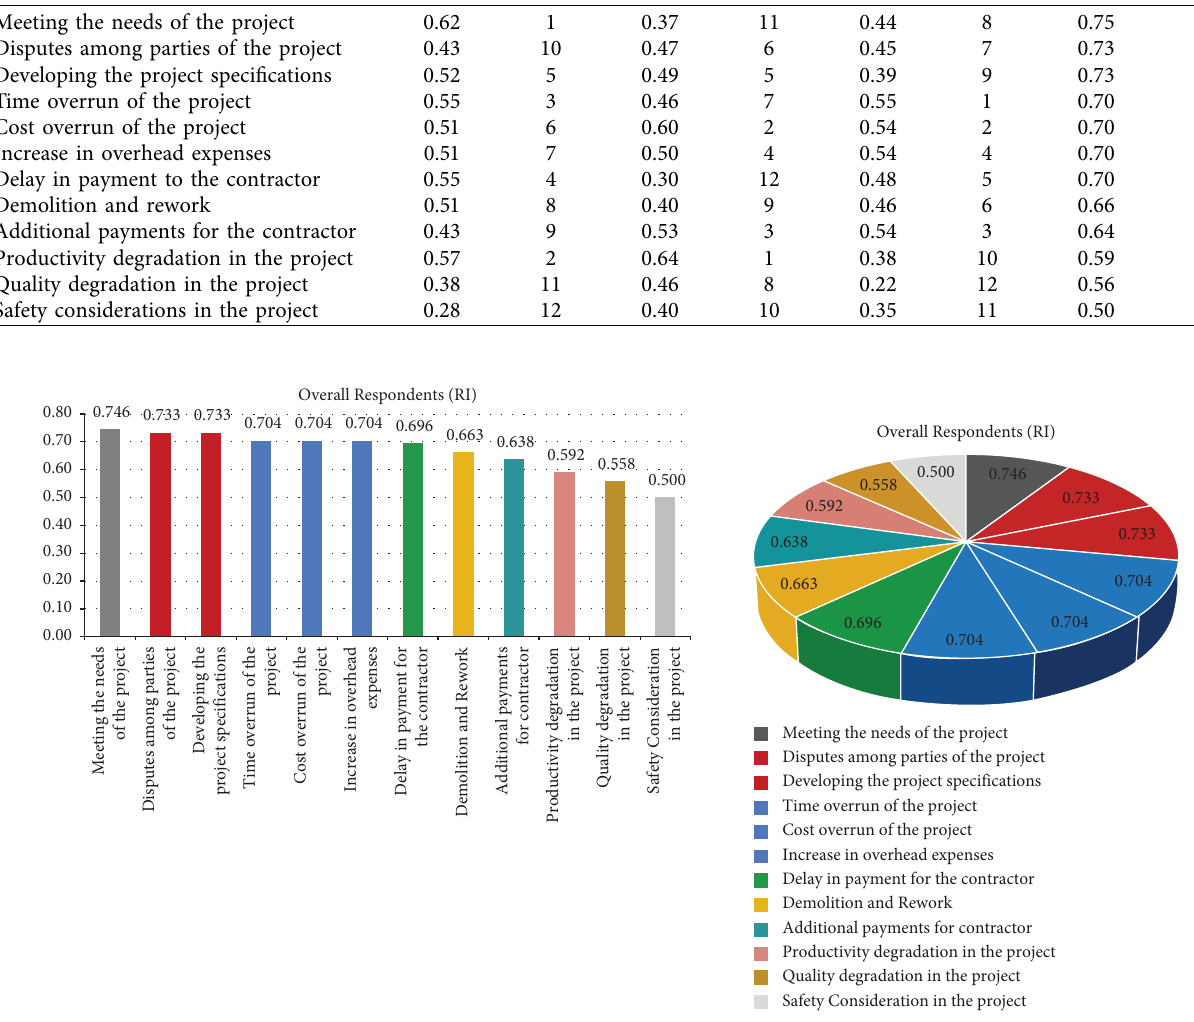
Figure 1: Frequency of impact of change orders on projects (overall responses).